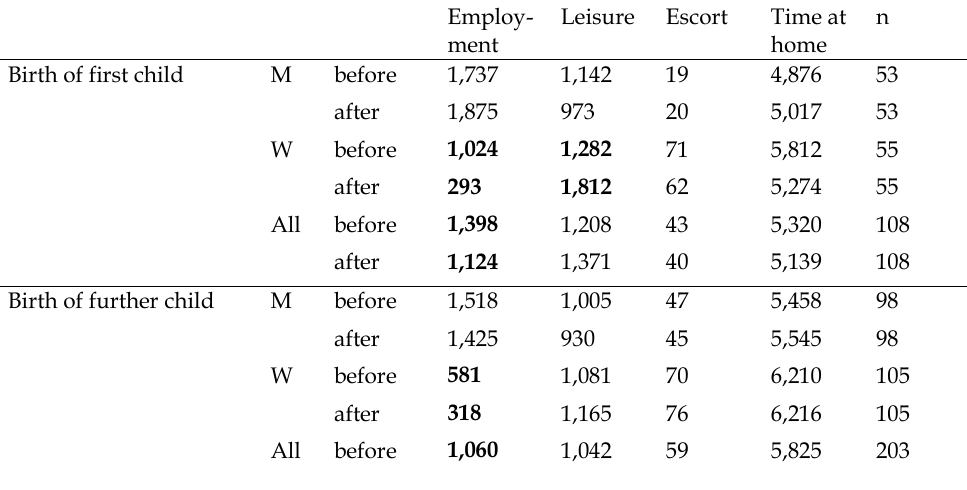
Table 3. Time use (minutes per week) according to key events, categorised by gender